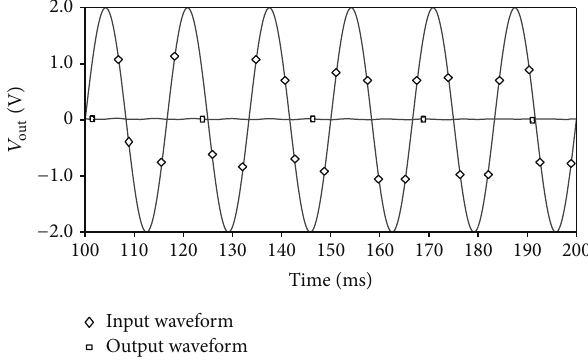
. con Figure 11: Input and output response at 60 Hz.